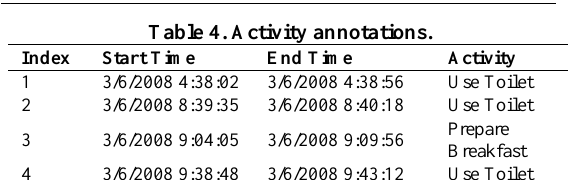
Table 4. Activity